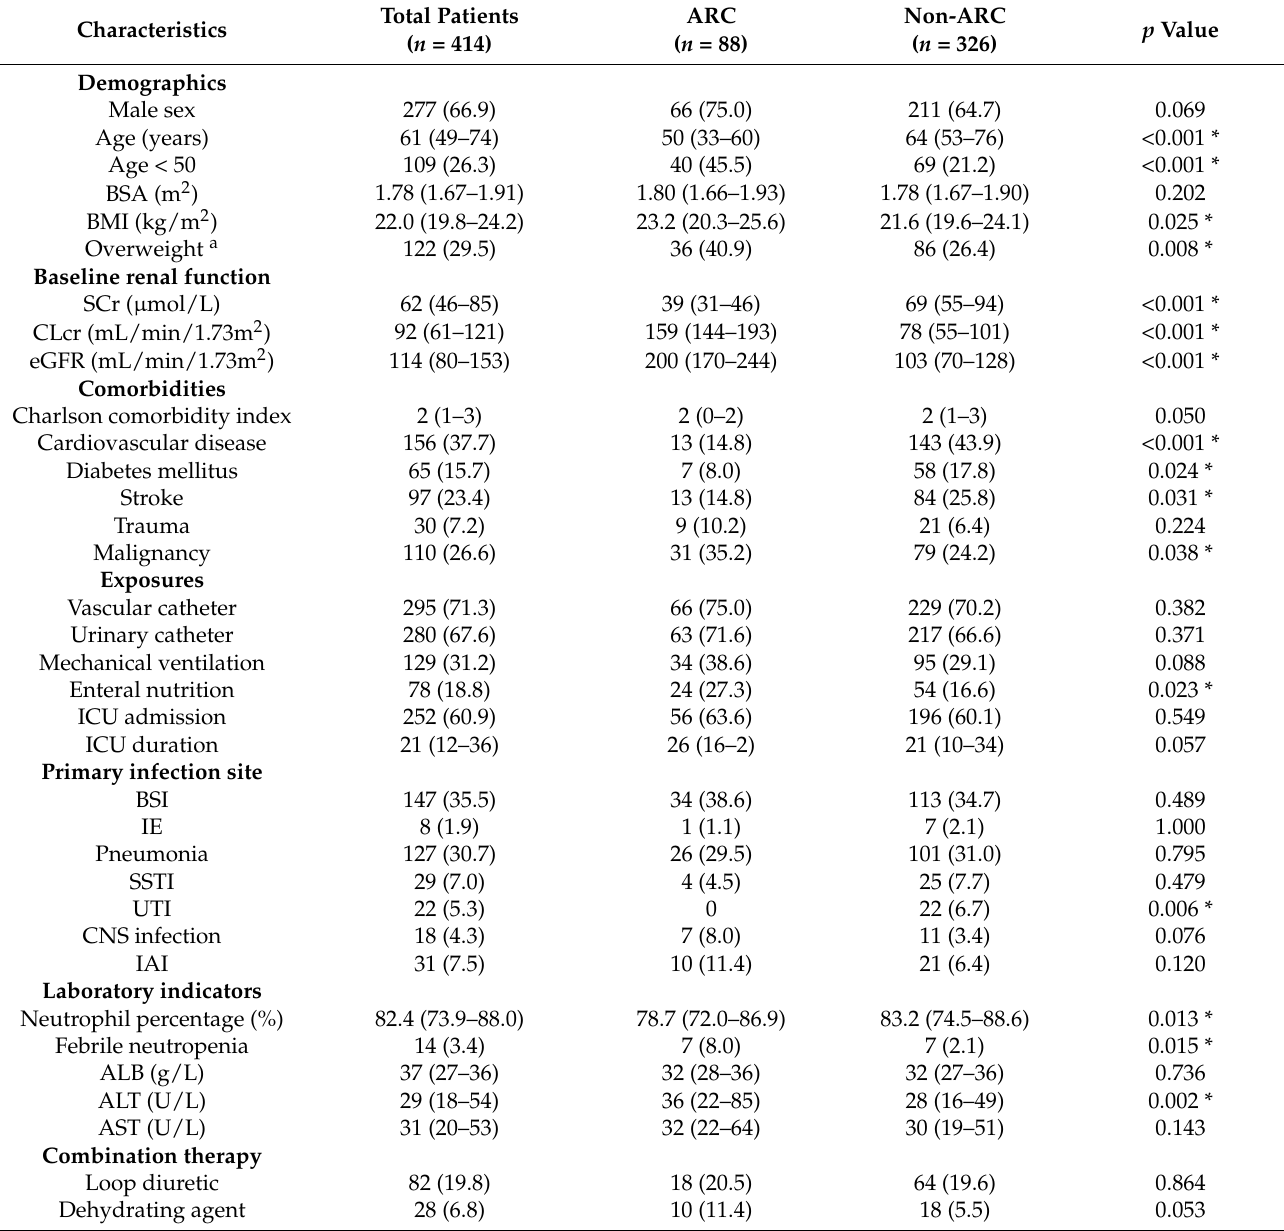
Table 1. Demographics and analysis for ARC risk